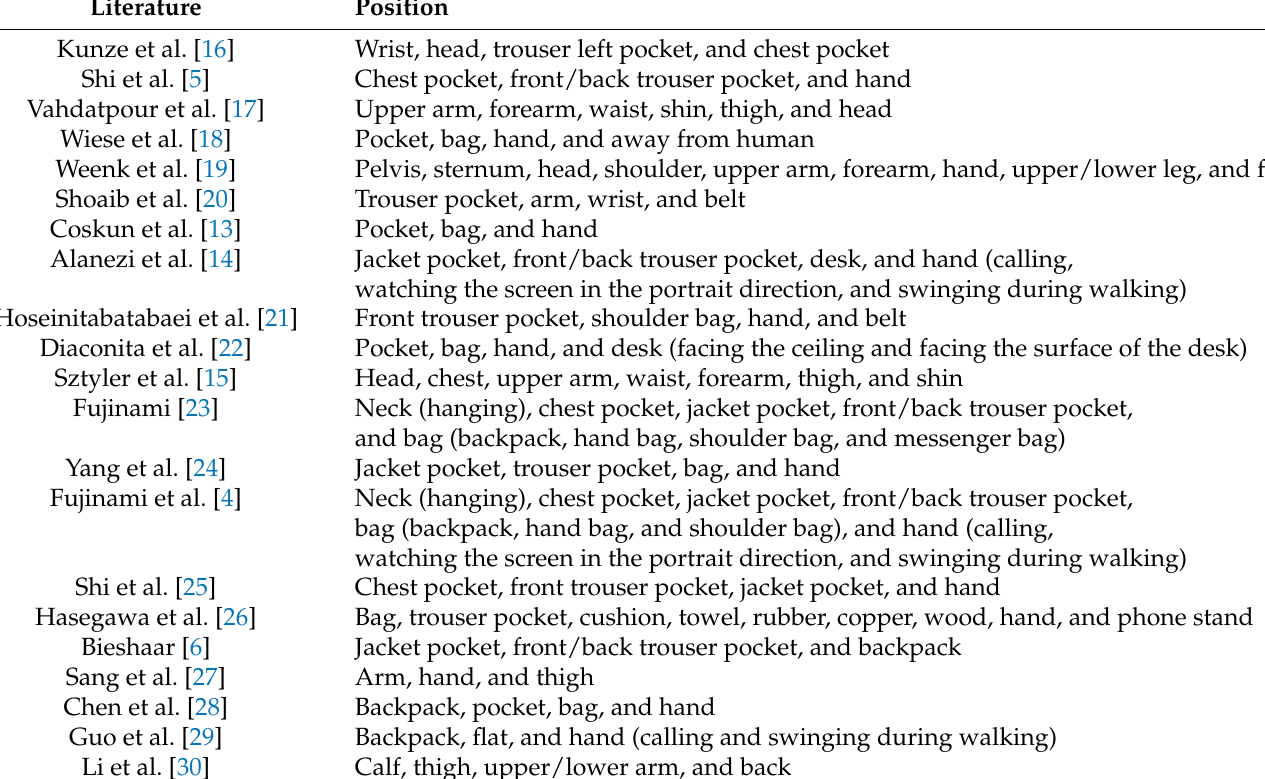
Table 1. Examples of on-body device position